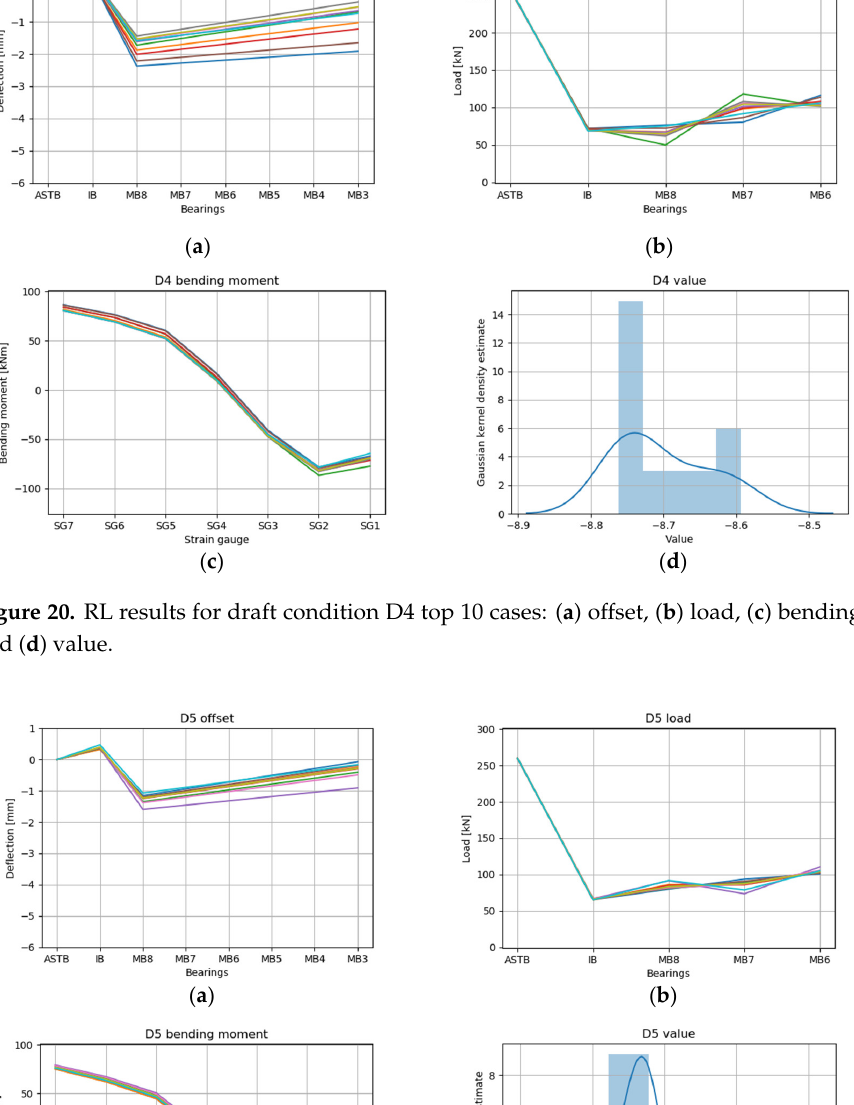
20 of 30 Figure 18. RL results for draft condition D2 top 10 cases: ( a ) offset, ( b ) load, ( c ) bending moment, and ( d ) value. ( d ) Figure 19. RL results for draft condition D3 top 10 cases: ( a ) offset, ( b ) load, ( c ) bending moment, and ( d ) value. 3.1.3. Scantling Draft Conditions (D4 and D5) The RL results of the scantling conditions D4 and D5 are depicted in Figures 20 and 21, respectively. As with the other results, the predicted values of the bending moment